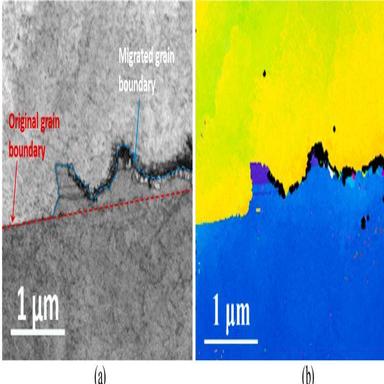
TKD maps showing the DIGM around the crack tip of Alloy 60Ni tested at 360 ◦C: (a) pattern quality map; (b) IPF map.